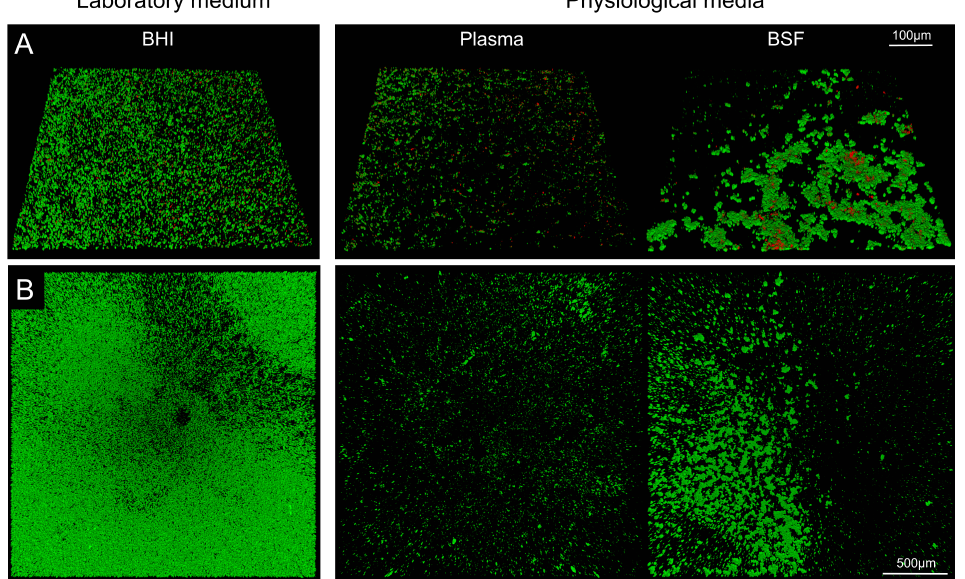
Figure 1. Three-dimensional reconstruction of sessile biofilm formation on titanium surface by means of CLSM. ( A ) Inclined view and ( B ) top view of biofilm grown in the presence of laboratory medium BHI or in physiological fluids, plasma ( left ) and bovine synovial fluid (BSF, right ). Upper panels show images acquired with a 20 × objective; lower panels show images acquired with a 5 ×